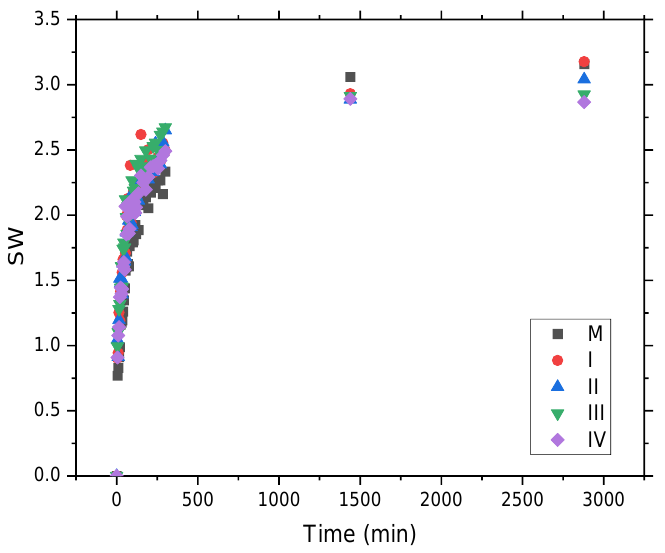
Figure 2. The curve of swelling degree as a function of time for hydrogel samples with increasing GO concentration (I, II, III, and IV) and control sample M. Table 1. The degree of swelling at different times for hydrogel samples with increasing GO concen- tration (I, II, III, and IV), and control sample